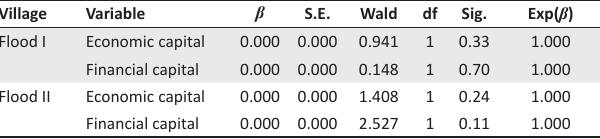
TABLE 6: Analysis of economic and financial capital by flood type.